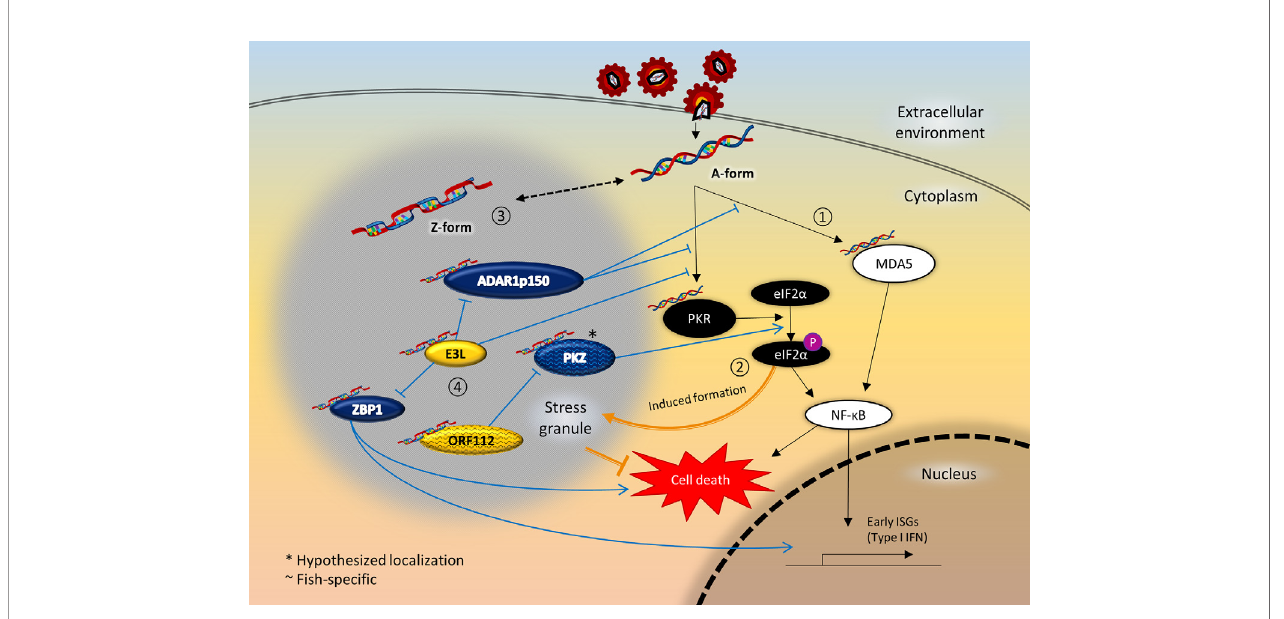
FIGURE 2 | Crosstalk between ZDBD-containing proteins, stress granules, and innate immunity signaling pathway following RNA virus infection. 1) Innate immune sensors like MDA5 and PKR are activated upon recognition of virus RNA in the cytoplasm, which in turn activates the NF- k B pathway culminating in expression of type I IFN. 2) At the same time, activated PKR also phosphorylates eIF2 a , causing stalled mRNA translation that induce the formation of stress granules. Stress granules are instrumental in promoting cell survival under cellular stresses like virus infection. 3) Most ZDBD-containing proteins have been shown to localize to stress granules, mediated via respective Z a domains. Therefore, it is possible that RNA can adopt Z-conformation more readily within stress granules. 4) ADAR1 p150 is a negative regulator of immune response protecting against autoimmunity and chronic in fl ammation, as edited RNA transcripts lose immunogenicity. On the other hand, ZBP1 activation triggers IFN response and cell death mechanism. The vaccinia virus E3L is an inhibitory protein towards the antiviral response of its mammalian host, which is dependent of its Z a domain. In fi sh, PKZ is a paralog that complements PKR-mediated pathways, as PKZ can be activated by Z-RNA binding. The cyprinid herpesvirus ORF112 protein antagonizes the activation of PKZ as the virus immune evasion strategy. Incidentally, PKR and MDA5 had also been reported to localize to stress granules. It is therefore plausible that the close proximity through localization to stress granules facilitate the crosstalk between ZDBD-containing proteins and immune recognition and signaling